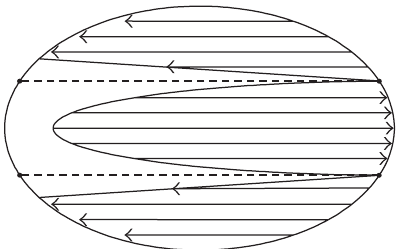
Figure 16: The traction distribution of pure rolling: Heathcote